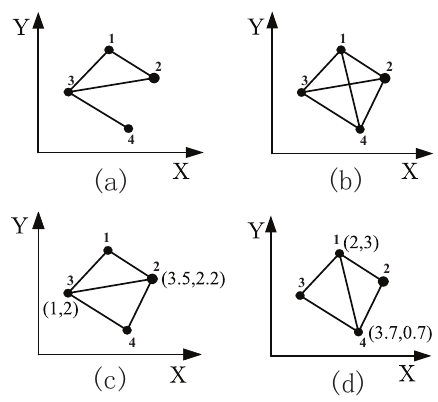
Figure 7. Flexible and rigid frameworks. ( a ) is flexible, while ( b ), ( c ) and ( d ) are rigid. Particularly, ( c ) is minimally rigid, and ( d ) is minimally weighted